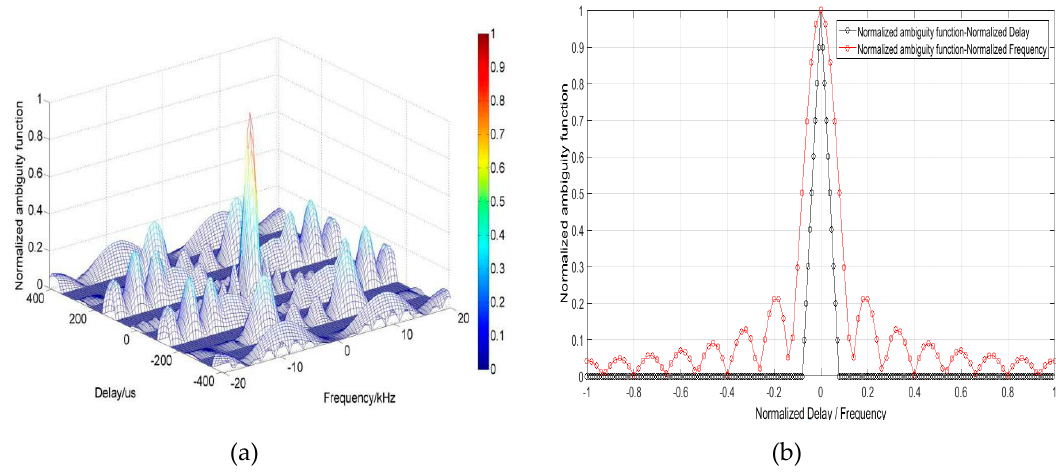
Figure 5. Normalized ambiguity function of complementary code: ( a ) Normalized ambiguity function; ( b ) Normalized ambiguity cut for Delay = 0 µ s and Frequency = 0 kHz. It has a “pushpin type”ambiguity. And the section of 0 kHz has only one main lobe with no side lobe. Thus, it is very suitable for soft target sounding.